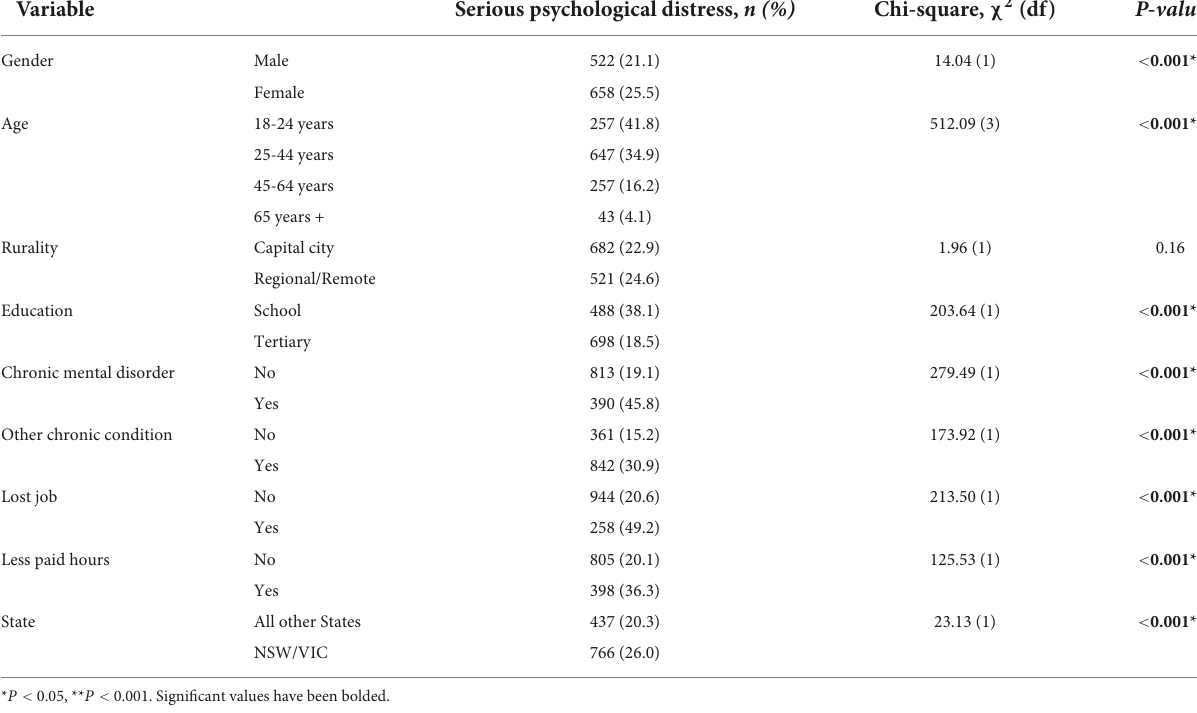
TABLE 2 Prevalence of serious psychological distress across demographics, health and pandemic-specific factors.